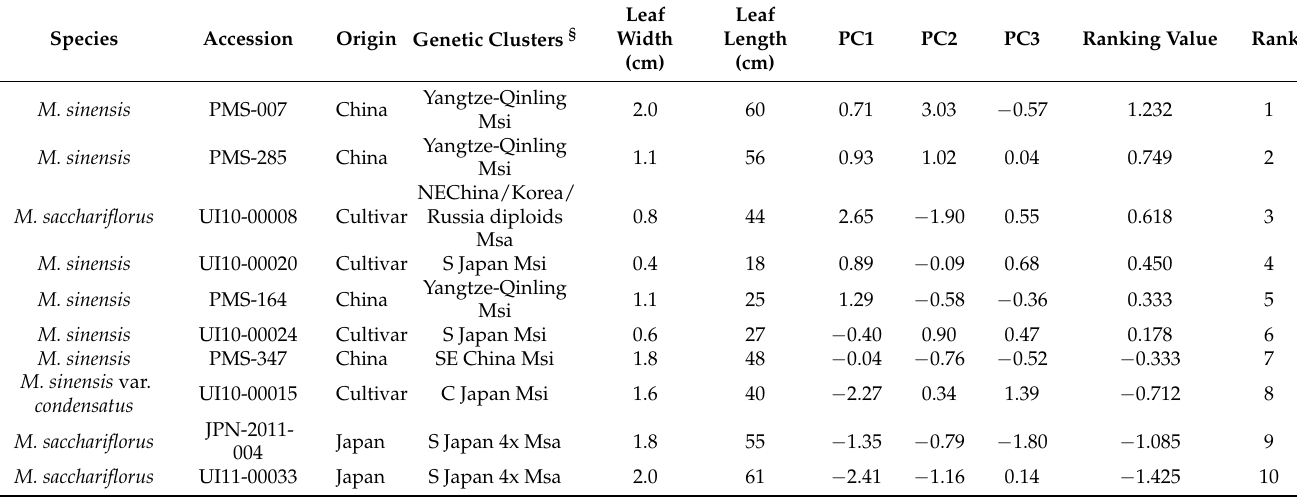
Table 6. Principal components analysis (PCA) ranking values † based on the drought stress index (25% soil moisture content) and the rank of drought-tolerance capacity of ten Miscanthus genotypes under slight drought stress ‡ in a precise comparison experiment of a precise comparison experiment at Hokkaido University (HU), Sapporo,